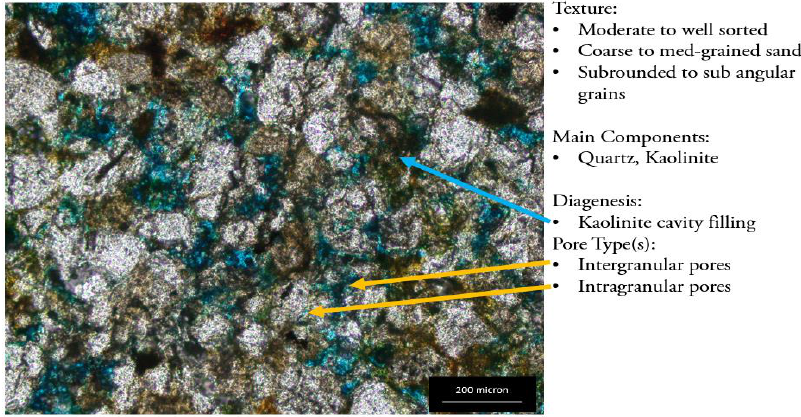
Figure 10. Textural and compositional features of L301 Temburong.